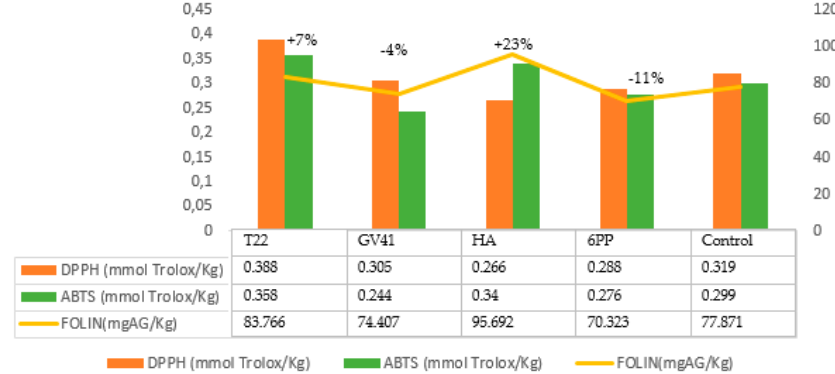
Figure 2. Phenolic content and antioxidant activity in the EVOO obtained by Leccino olives.